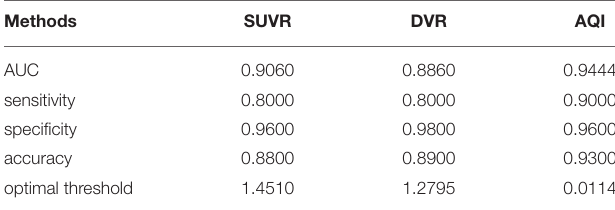
TABLE 2 | The classification performance of SUVR, DVR, and AQI on training set.